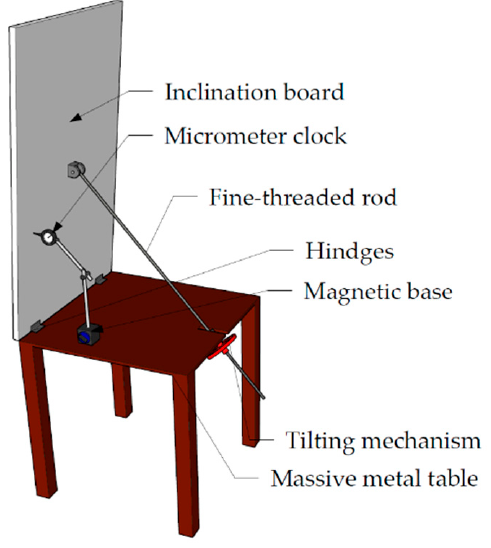
Figure 4. Tilt test board setup.